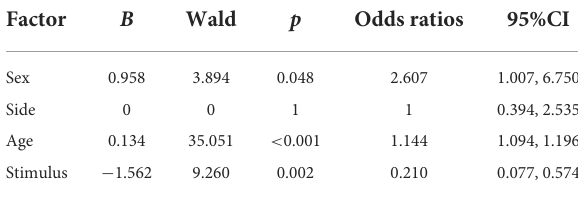
TABLE 3 Logistic regression analysis to evaluate factors with odds ratios (95% confidence interval) for absent oVEMP responses.